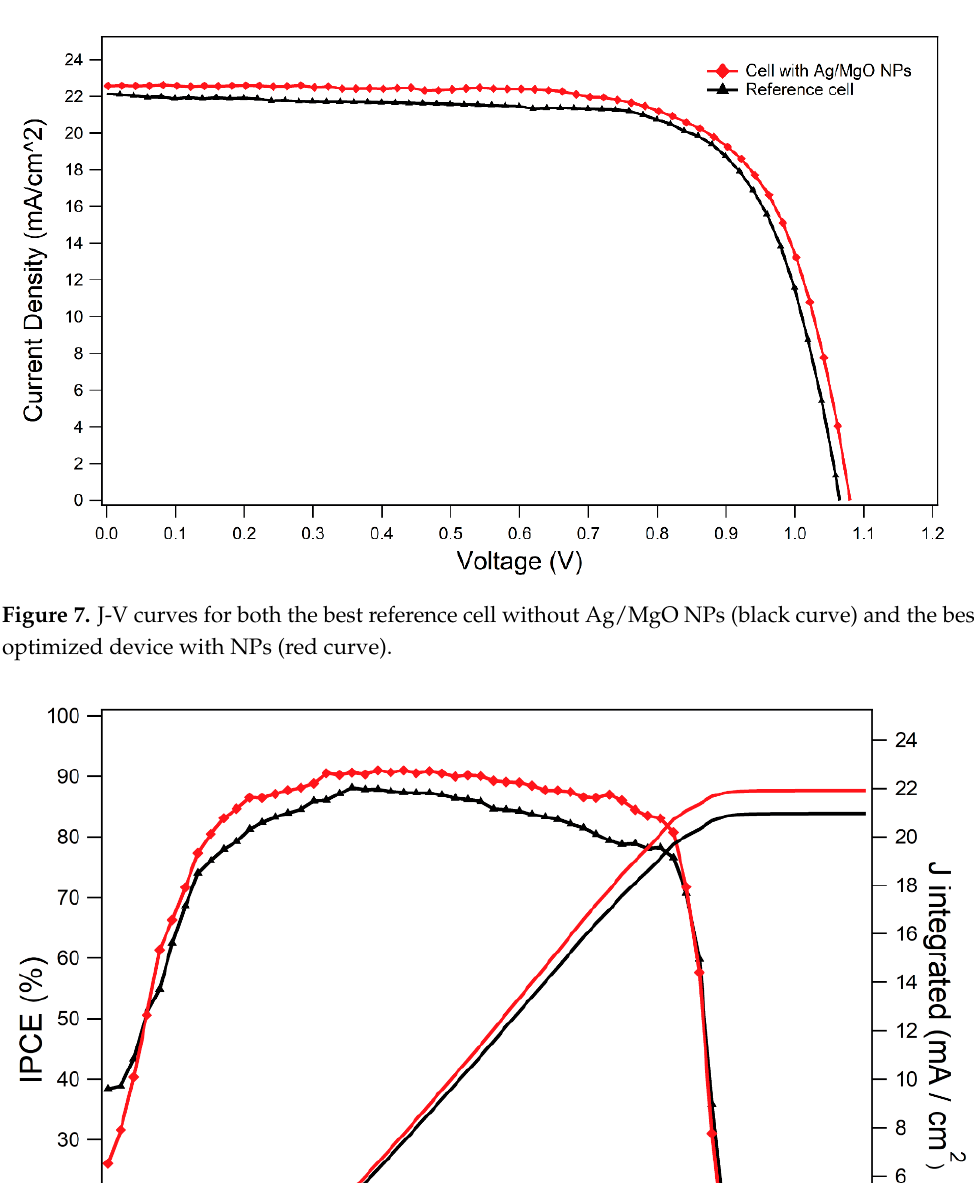
12 of 18 Table 1. Main parameters, with their standard deviations, for devices ranging between 0.0% and 10.0% of surface coverage in Ag/MgO NPs atop an m ‐ TiO 2 layer. Ag/MgO Coverage %